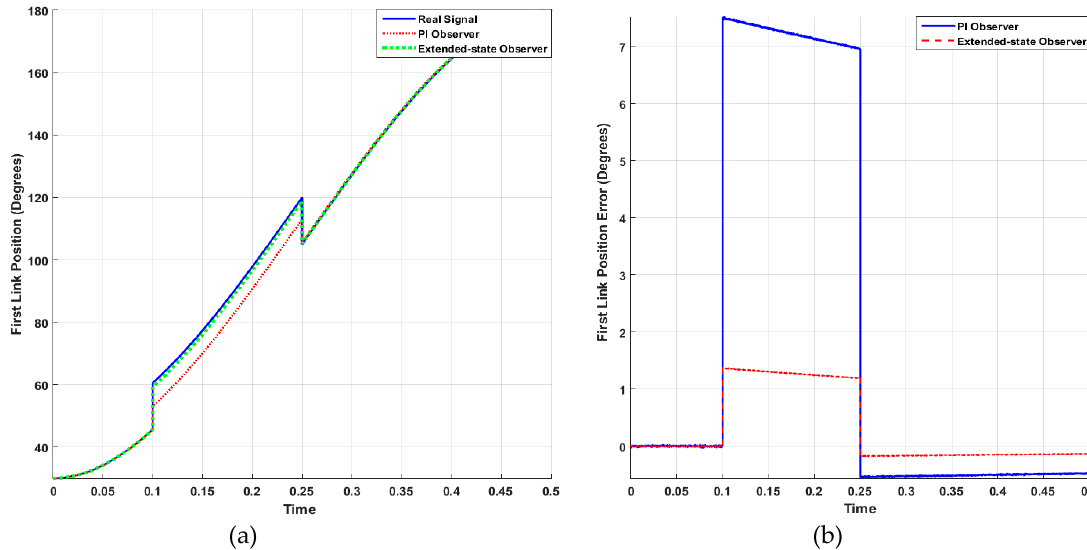
Figure 4. Sliding mode extended-state ARX–Laguerre PI observer method for first link fault estimation in the faulty condition: ( a ) Real and estimated output position and ( b ) estimation error signals.